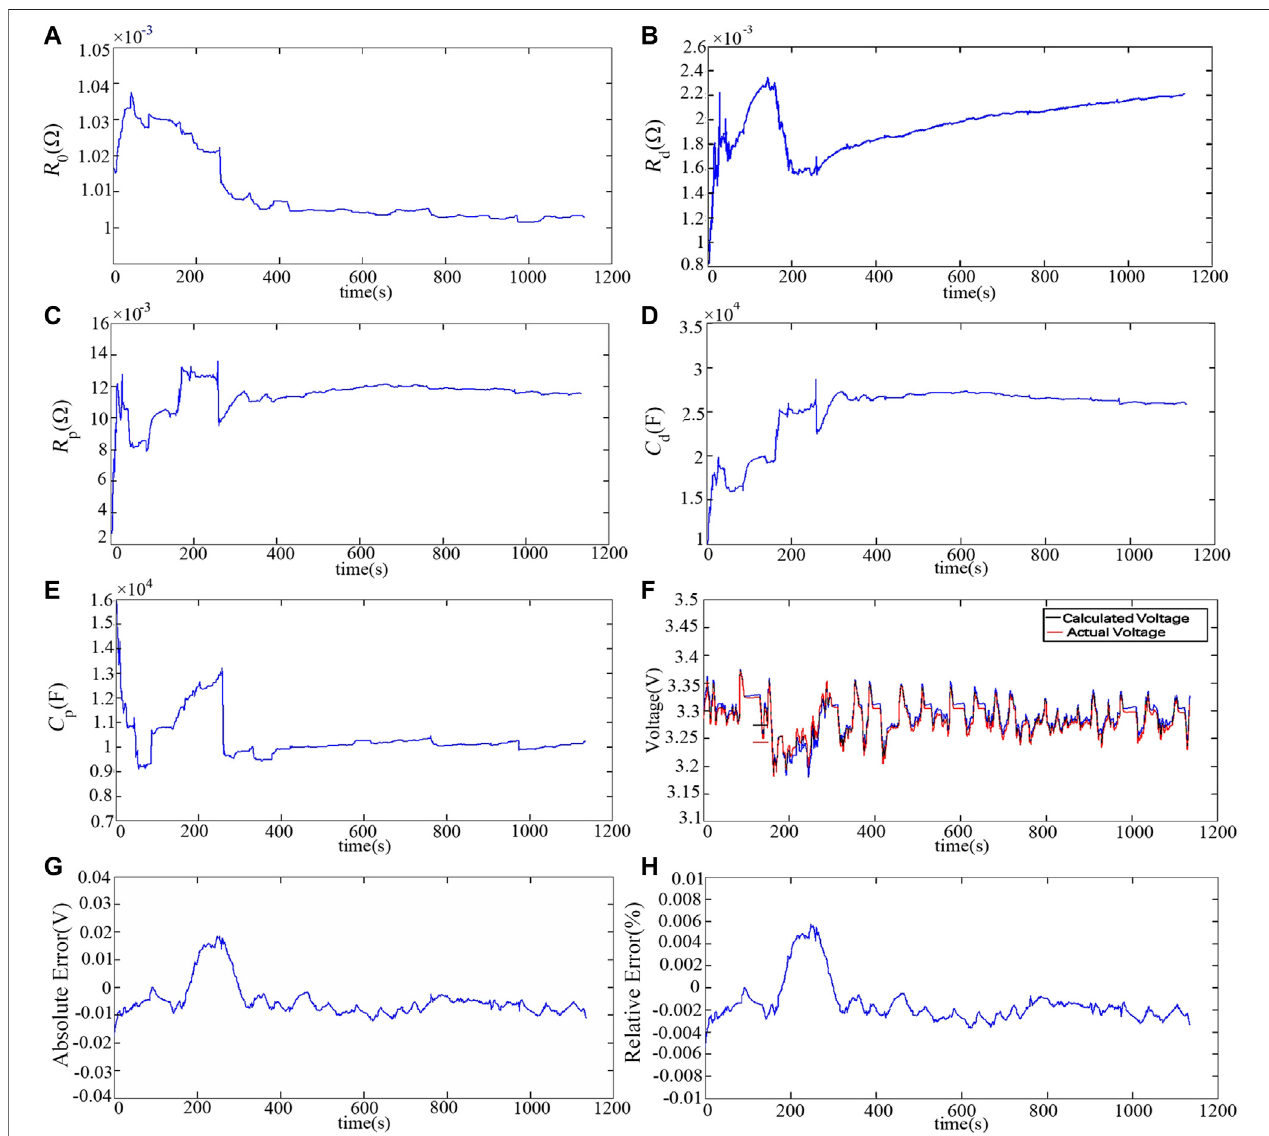
FIGURE 4 | (A) Convergence process of R 0 . (B) Convergence process of R d . (C) Convergence process of R p . (D) Convergence process of capacitance C d . (E) Convergence process ofcapacitance C p . (F) Comparison betweencalculated voltage and actual voltage. (G) Absoluteerror of calculated voltage compared withactual voltage. (H) Relative error of calculated voltage compared with actual